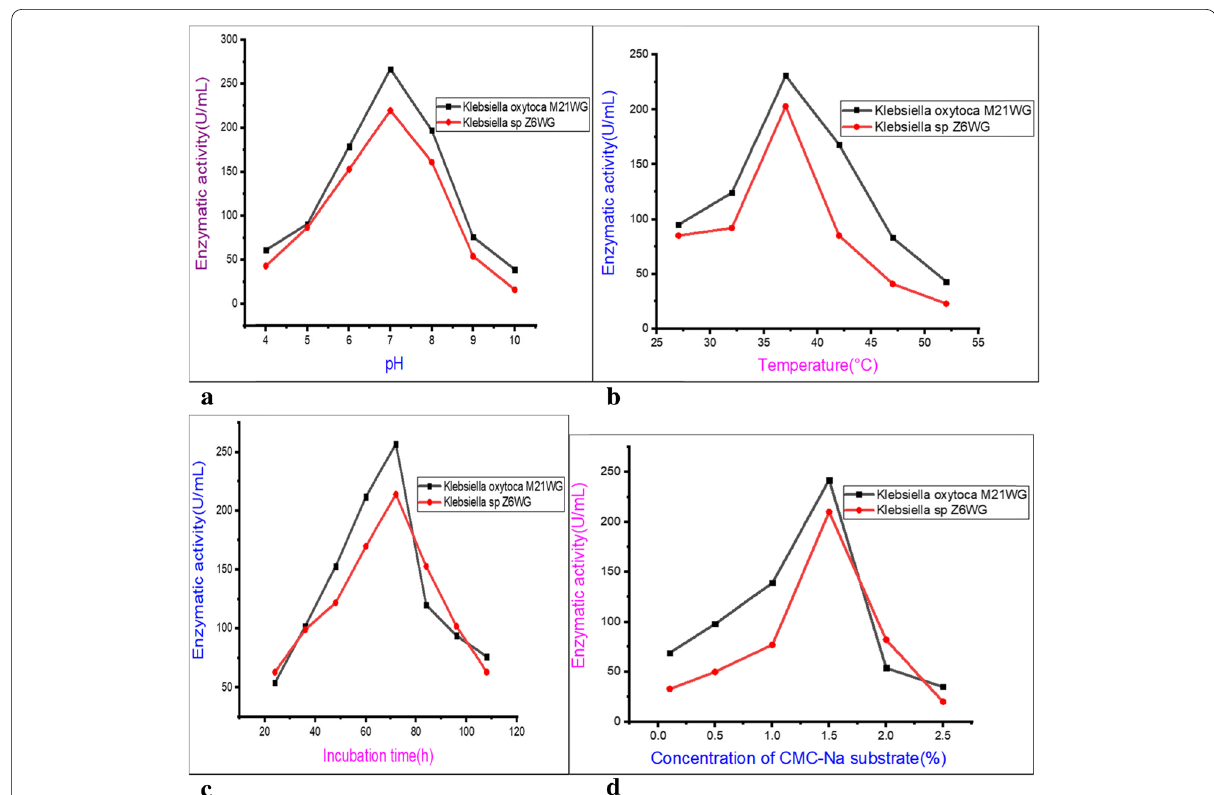
Table 4 The purification step of cellulase isolate from Klebsiella oxytoca (M Enzyme